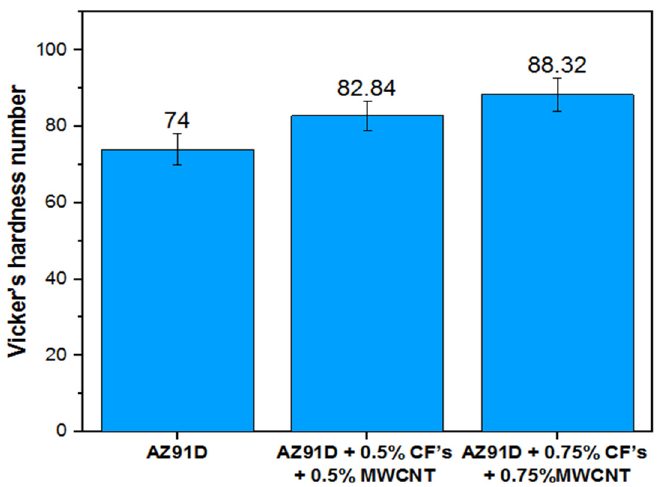
Figure 4. Variation of Vickers hardness number in the Mg AZ91D hybrid composite with varying weight percentages of CF and MWCNT reinforcements.